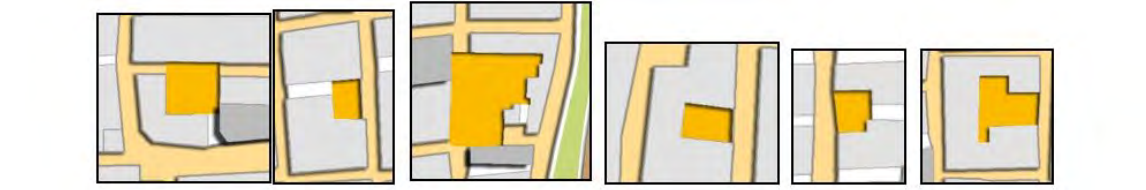
Figure 19. (Intimate/ secondary spaces of Rashid historic core)